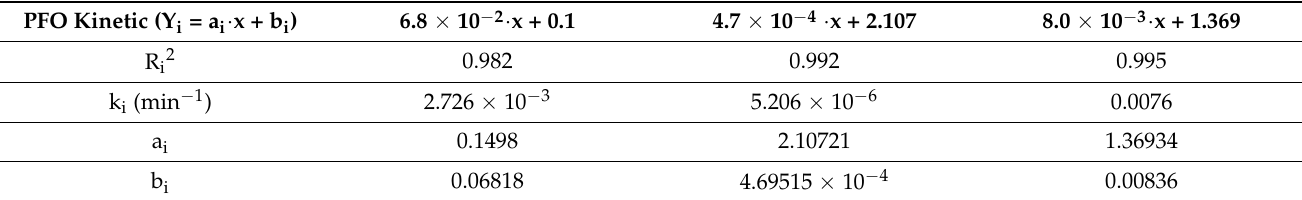
Table 3. The PFO Kinetic parameters of CV degradation during the heterogeneous photo-Fenton process (conditions: spontaneous pH, CV = 10 mg/L, H 2 O 2 = 30 mg/L, catalyst concentration 1.0 g/L). PFO Kinetic (Y i = a i · x + b i )